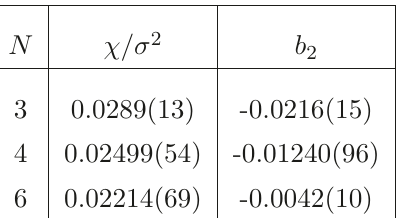
Table 4 . Summary of continuum extrapolations for N = 3 , 4 and 6. Values for N = 3 are taken from ref. [25].